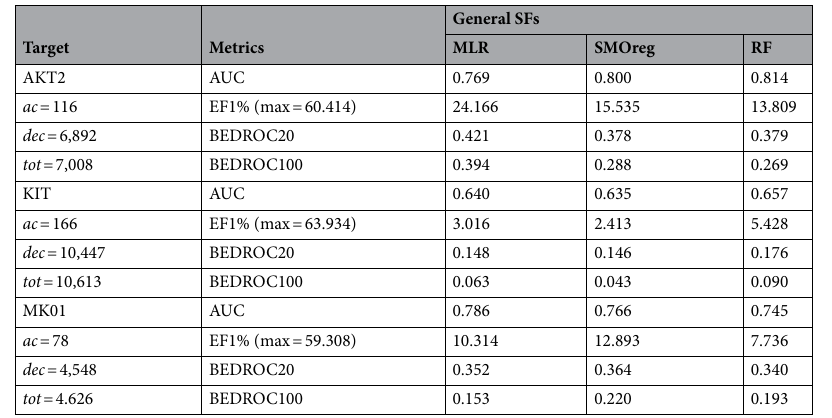
Table 7. Screening success of the general scoring functions trained with MLR, SMOreg and RF evaluated on the AKT2, KIT, and MK01 datasets from DUD-E. ac , dec and tot are the number of active, decoy compounds and the total number of molecules in the final dataset ( i.e., compounds that were docked and rescored with DockThor and DockTScore, respectively). Only the top-scored protonation state of each compound according to each scoring function (SF) was kept.